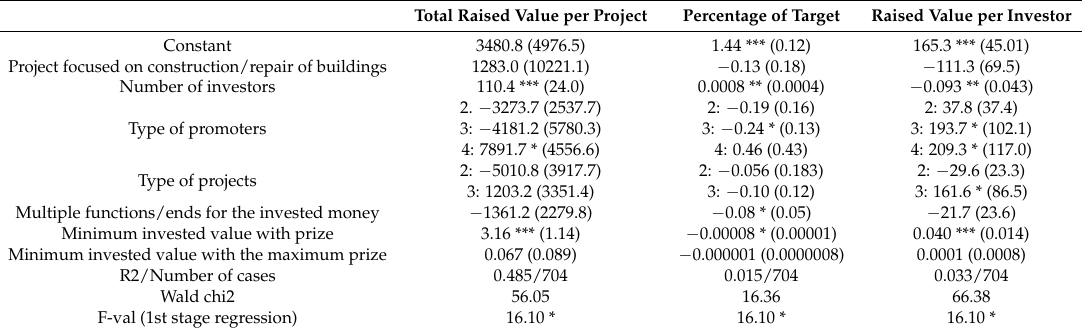
Table 3. Estimations for total funded value, percentage of target, and value per investor (2013–2017).